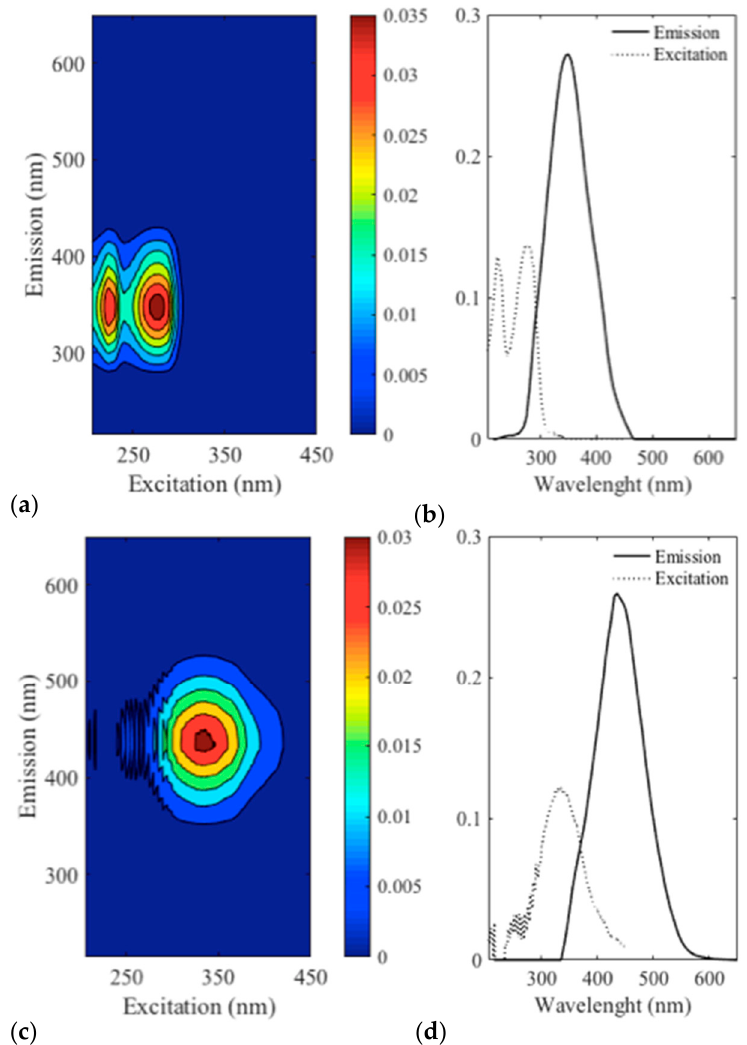
Figure 3. Emission and excitation emission matrix and Parafac fingerprints obtained from the experimental wines ( a ) contour plot for component 1 and ( b ) respective loading plot; ( c ) contour plot for component 2 and ( d ) respective loading plot.